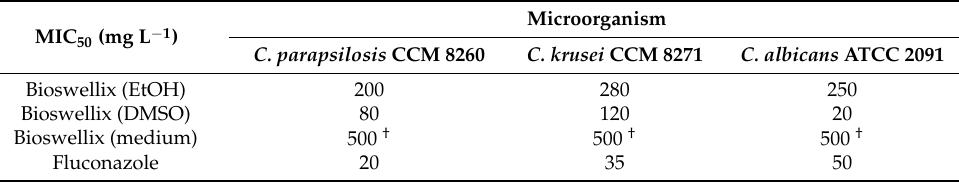
Table 1. Minimum inhibitory concentrations (MIC 50 ) of Bioswellix and fluconazole for C. albicans ATCC 2091, C. parapsilosis CCM 8260 and C. krusei CCM